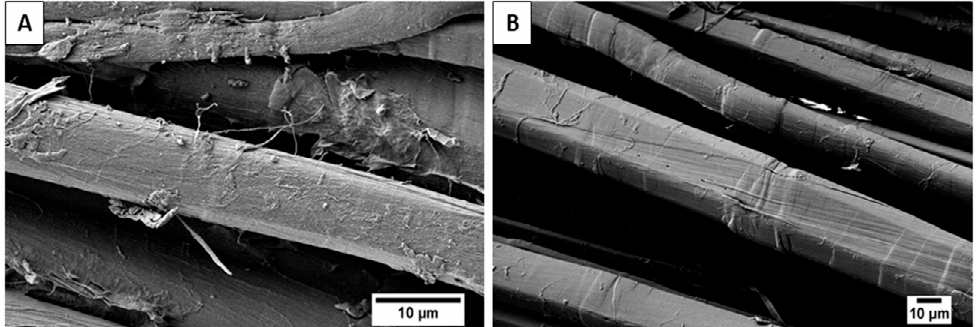
Figure 2. Comparison between the lateral surface of the untreated flax fibres ( A ) and the flax fibres treated with 5 wt % Peclyve for 6 h ( B ).